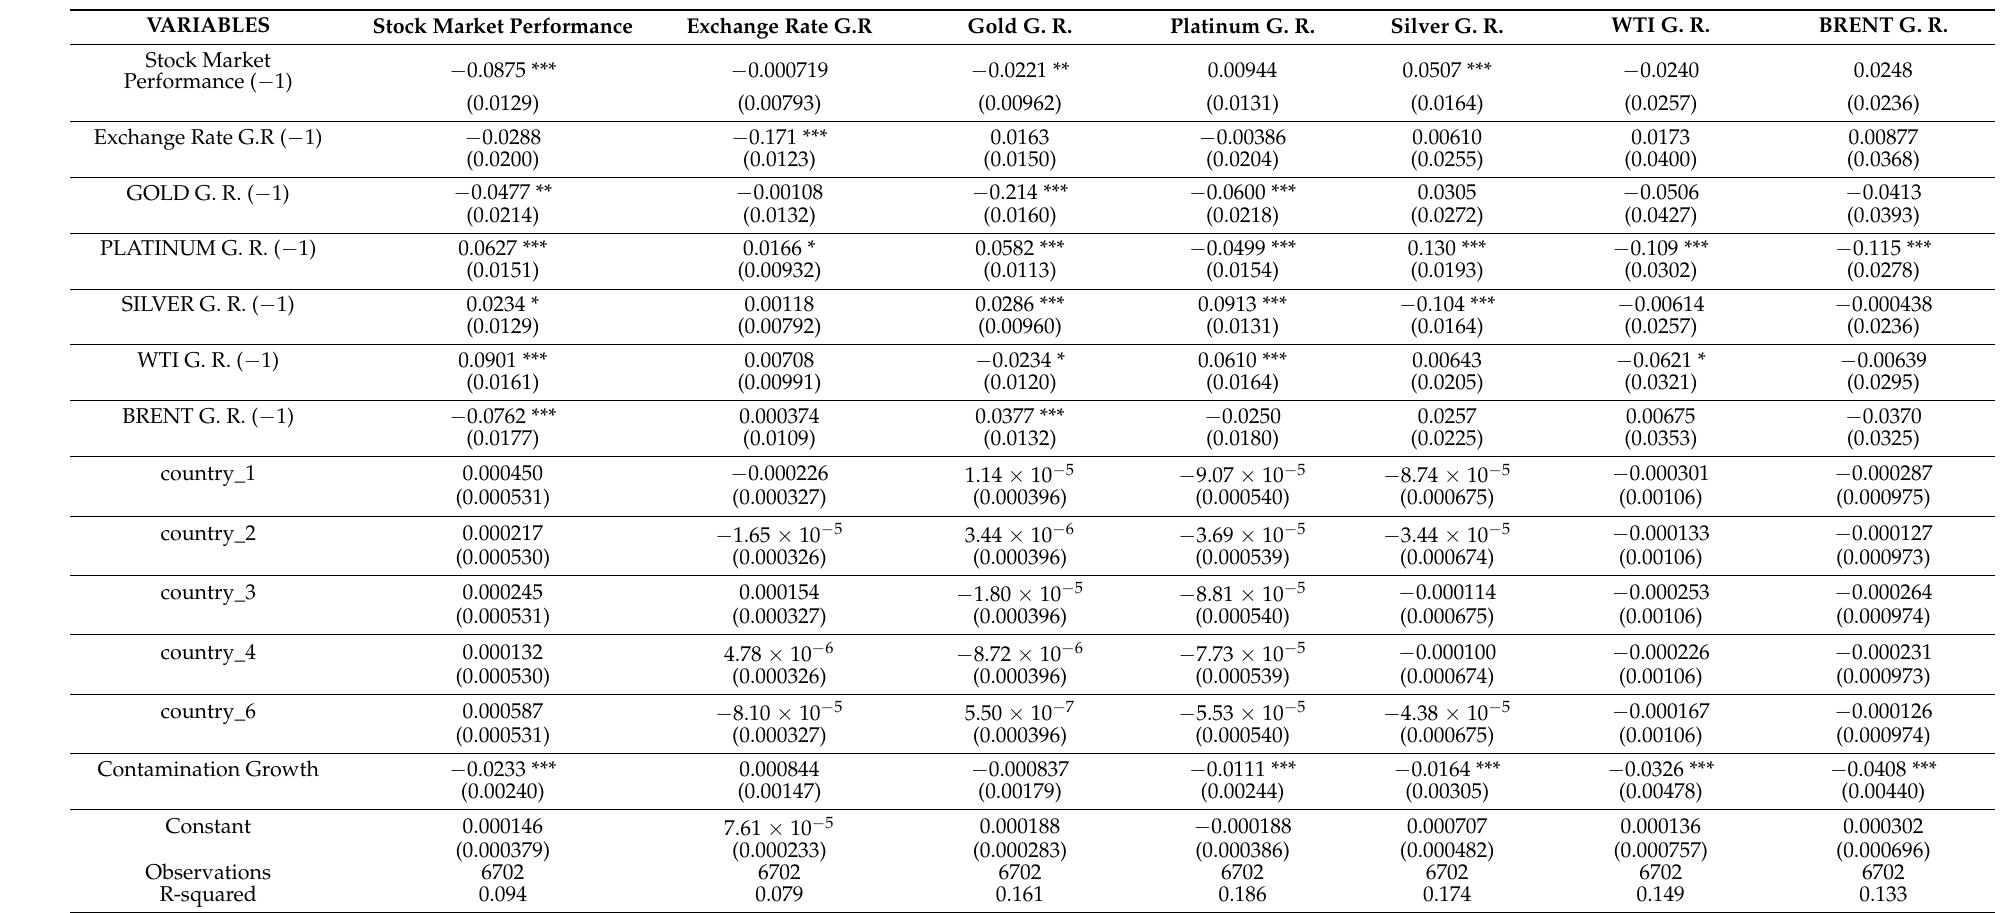
Table A8. SUR (FGLS)